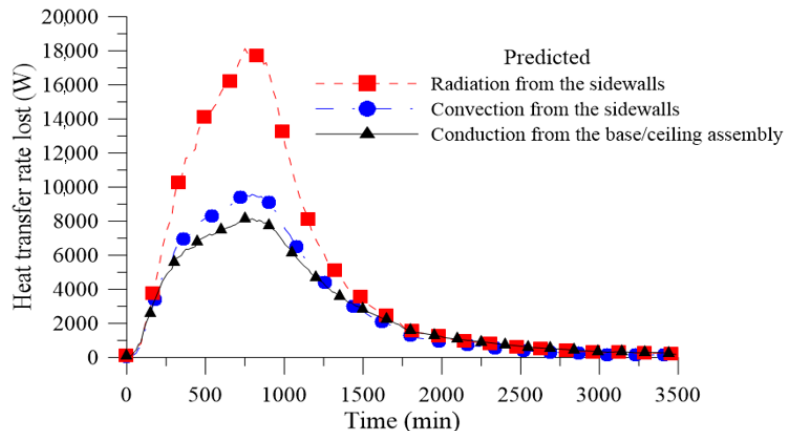
Figure 9. Heat losses of the kiln as a function of time.